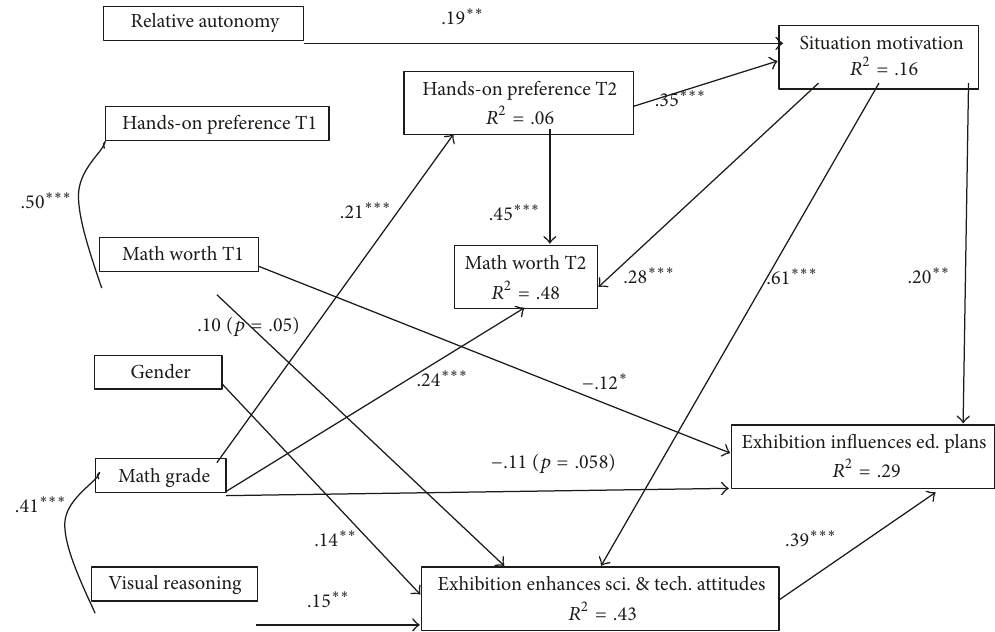
Figure 3: The final path model ( ∗ 𝑝 < .05 ; ∗∗ 𝑝 < .01 ; ∗∗∗ 𝑝 < .001